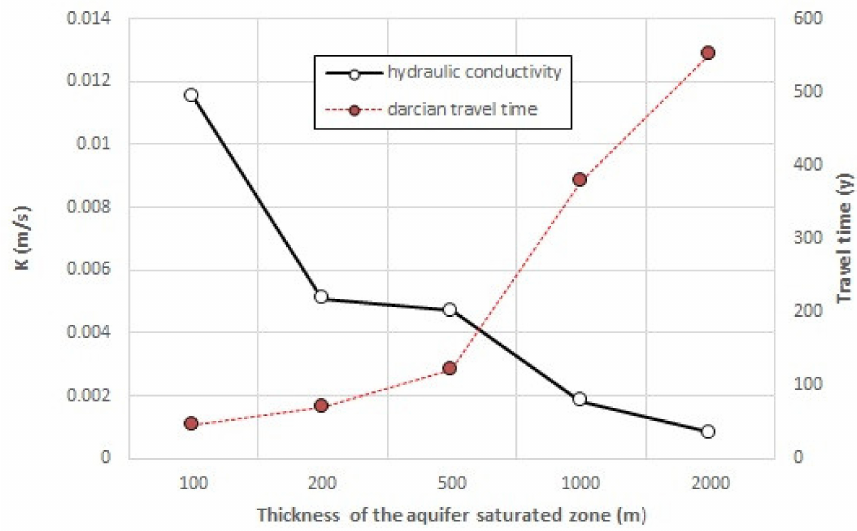
Figure 11. Thickness of the aquifer’s saturated zone (TSZ) vs. hydraulic conductivity (K); the Darcian travel time ( t s ) has been also plotted.